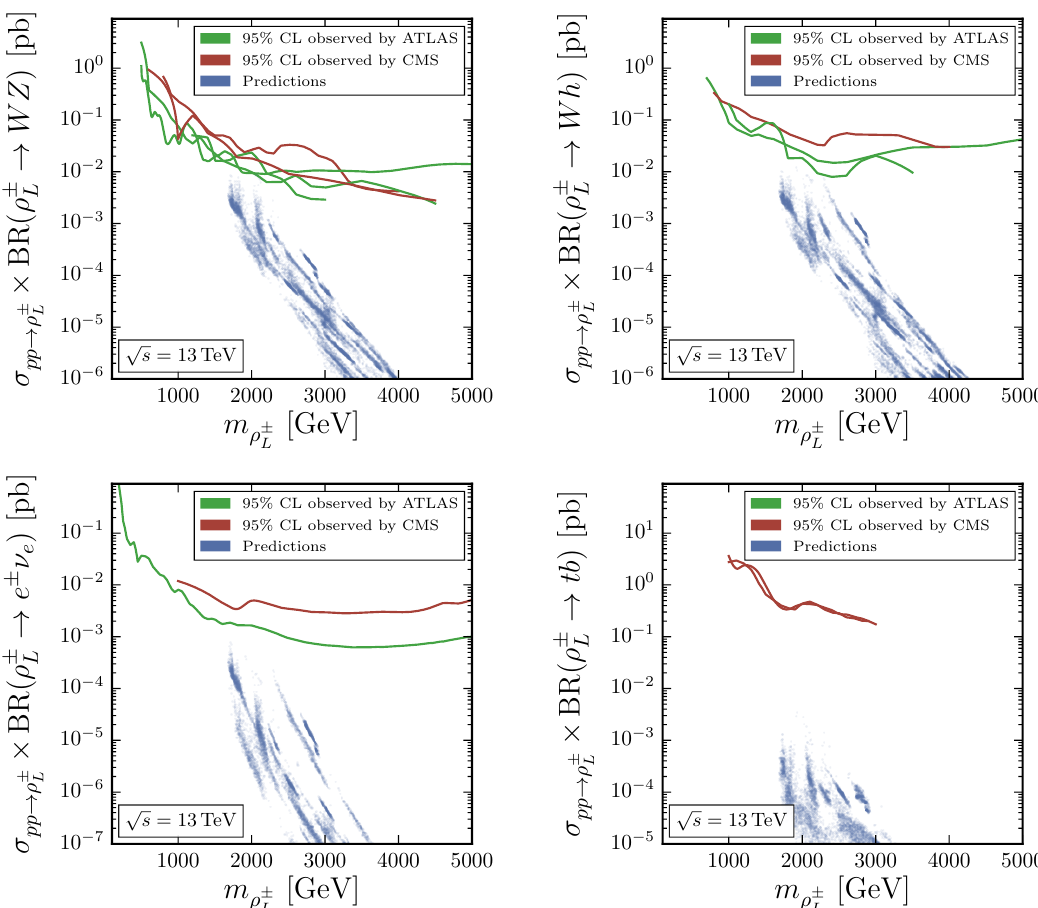
Figure 7 . Experimental bounds from ATLAS and CMS and predictions from viable parameters points of the (cid:26) (cid:6) production cross section times the branching ratio into WZ (upper-left), Wh L(cid:22) (upper-right), e (cid:6) (cid:23) e (lower-left) and tb (lower-right). The analyses shown in the plots are listed